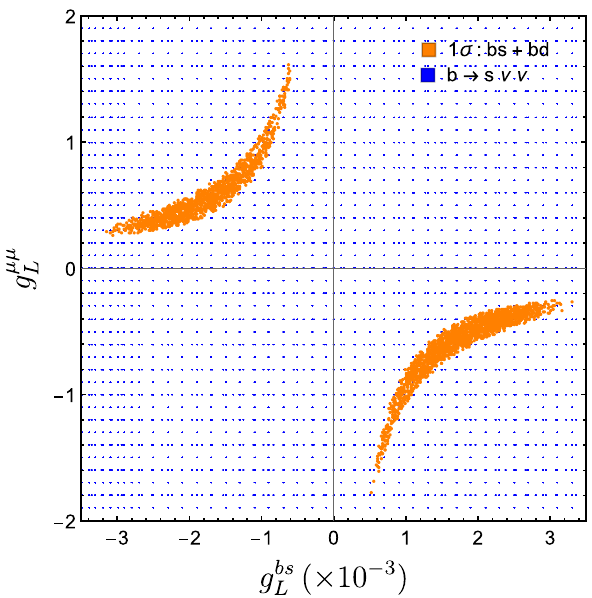
Fig. 9 Comparison of favored NP parameter space using b → s ν ¯ ν data and combined fit to b → s , b → d and neutrino trident